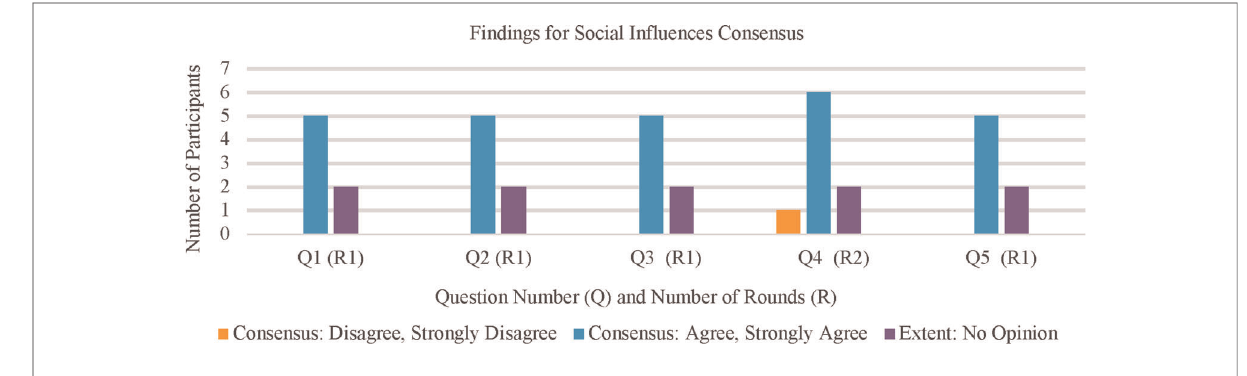
FIGURE 2 Accumulated results of the social in fl uences